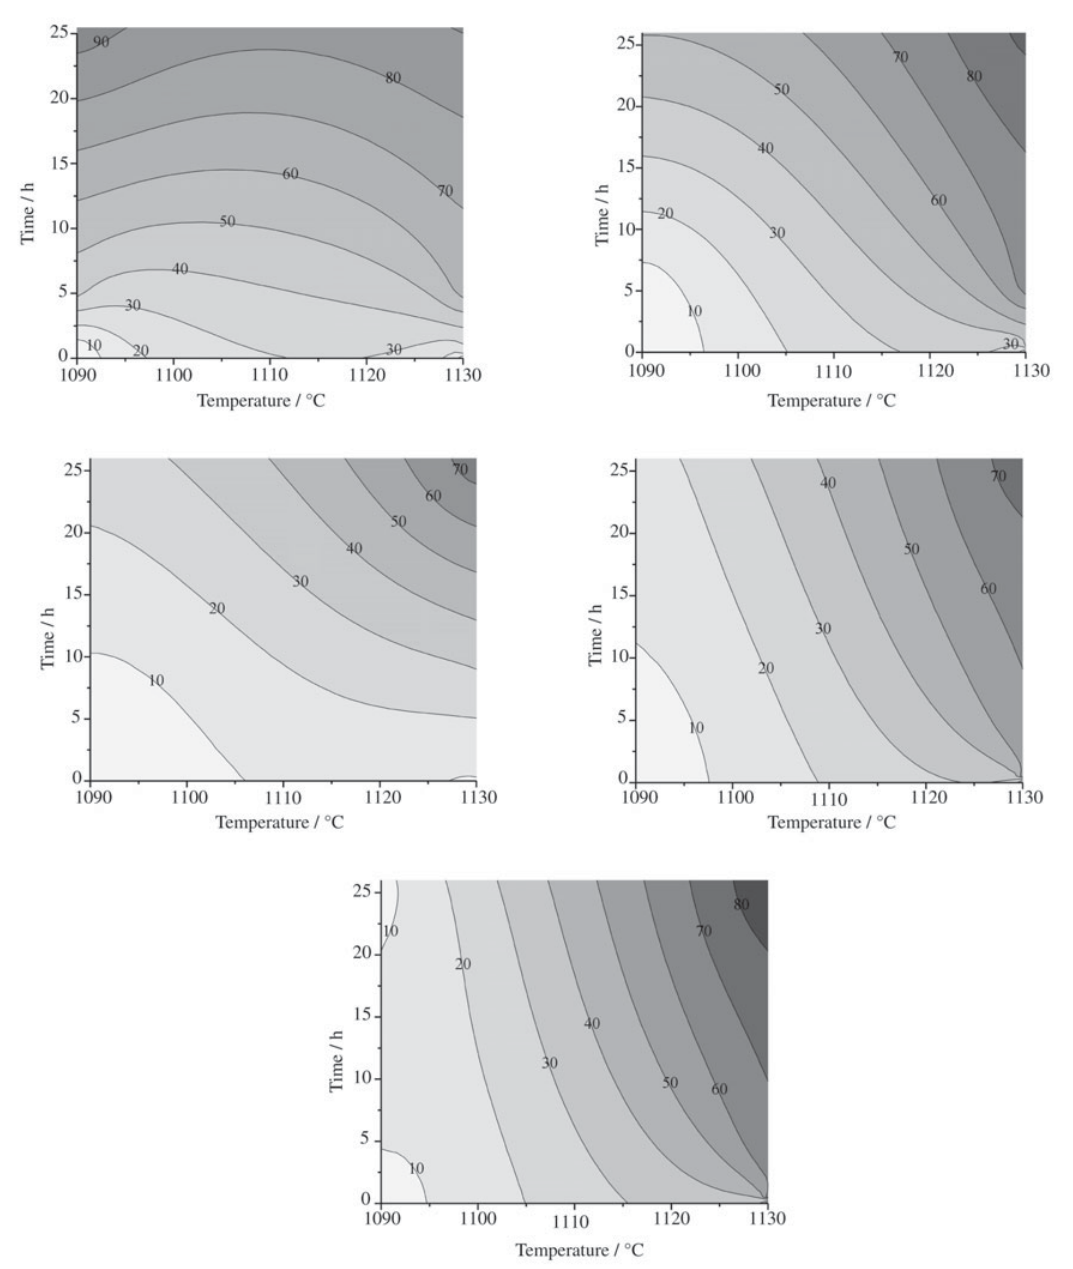
Figure 1. Evolution of the volumetric fraction of gross grains as a function of the annealing temperature and time for different start conditions. a) without start treatment (solution annealed); and ageing treatments for 1000 h at b) 600 °C; c) 700 °C; d) 800 °C; e) 900